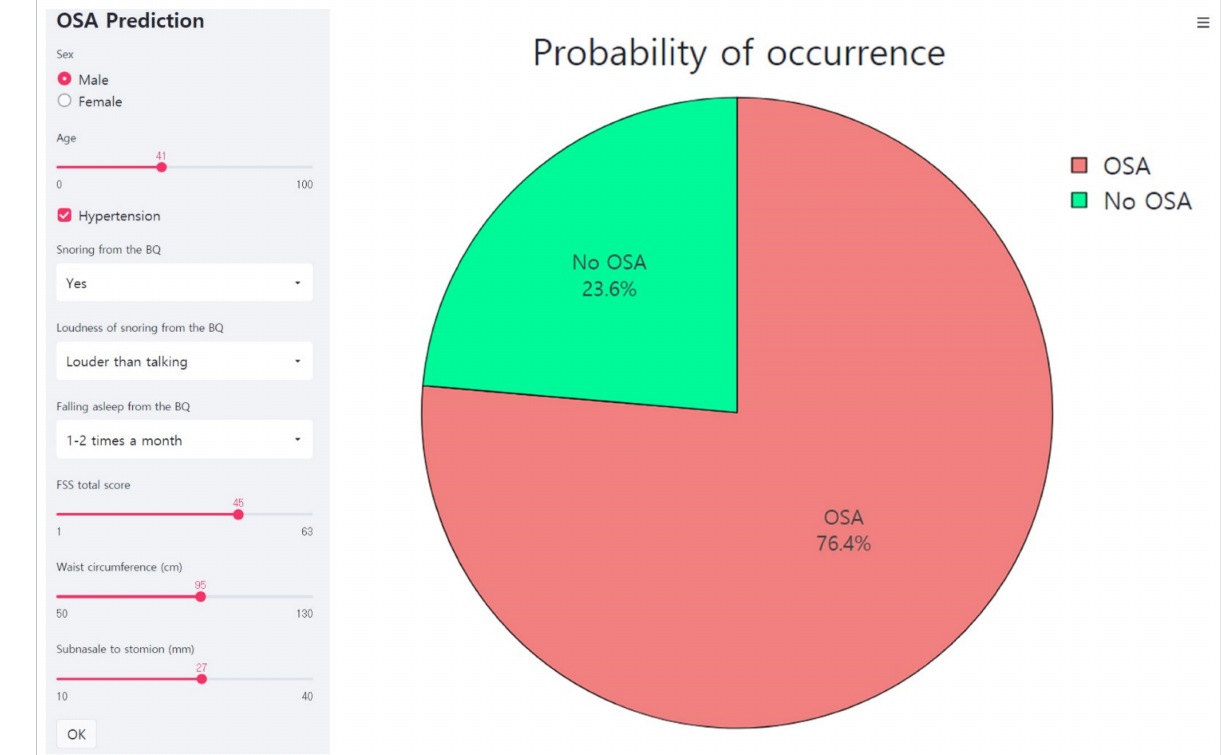
Figure 5. Web page-based application for the OSA prediction. This is an example of inputting data of a male participant into an application. The application predicts the probability of the OSA as 76.4%. FSS, Fatigue Severity Scale; BQ, Berlin Questionnaire; OSA, obstructive sleep